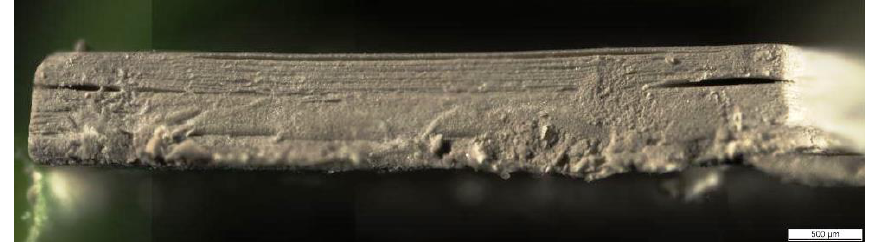
Figure 5. Side view of AlN green body fabricated from the dispersion containing 40 vol % of solid loading and 0.5 wt % ITX, 0.25 wt % TEMED.